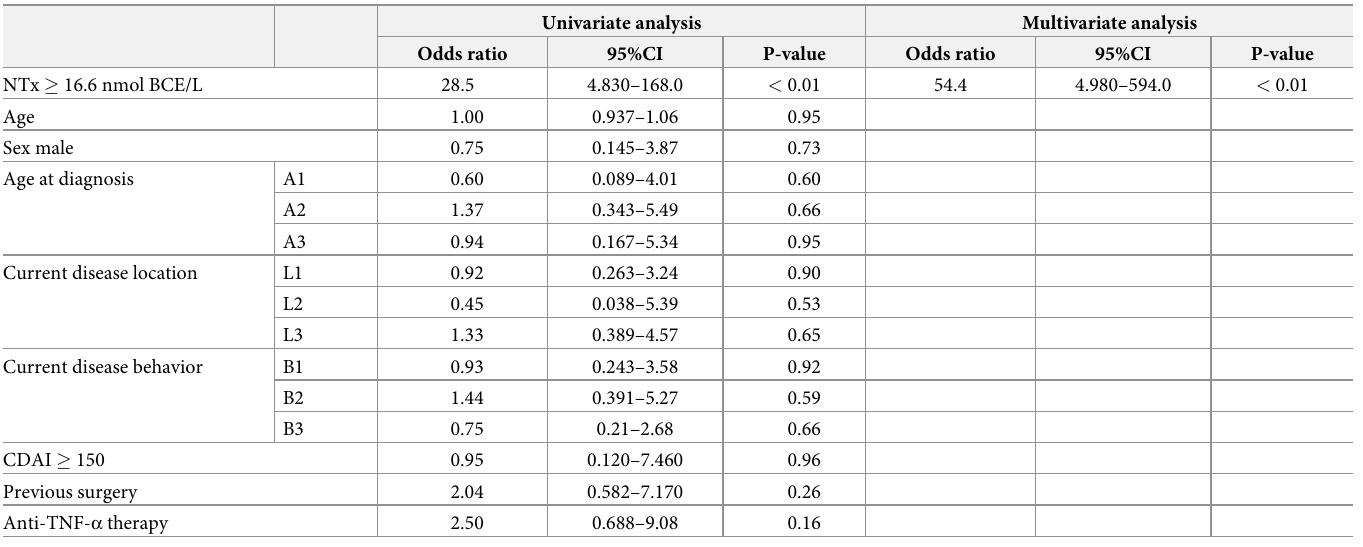
Table 4. Multivariate analysis for predicting Z score decrease during 2 years.